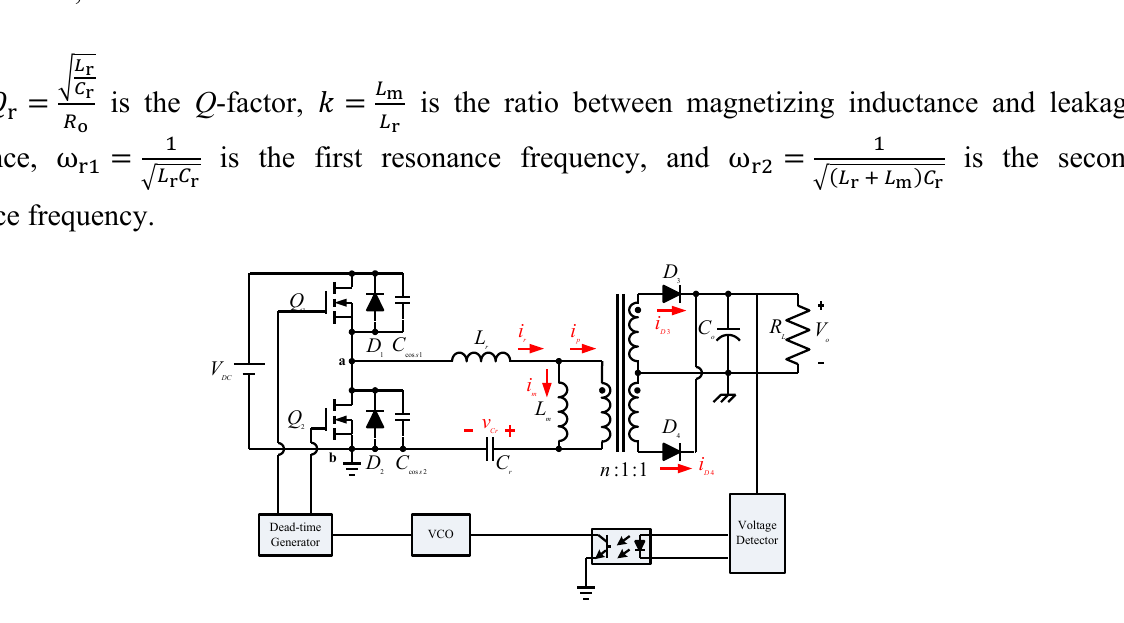
Figure 3. Schematic of LLC resonant converter with basic functional blocks. VCO: voltage control oscillator.